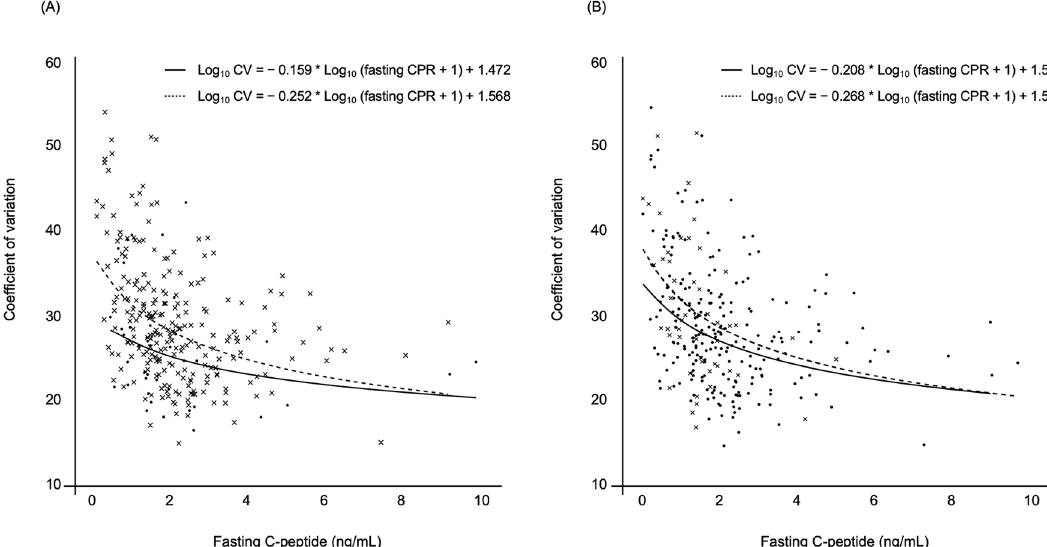
Figure 4. Scatter plot and prediction curve of fasting C-peptide versus coefficient of variation for ( A ) patients treated with an alpha-glucosidase inhibitor (n = 43, Scatter plot; closed circle, prediction curve; solid line) and those treated without an alpha-glucosidase inhibitor (n = 241, cross, broken line). ( B ) Shows data for patients treated with a dipeptidyl peptidase-4 inhibitor (n = 194, closed circle, solid line) and those treated without a dipeptidyl peptidase-4 inhibitor (n = 90, cross, broken